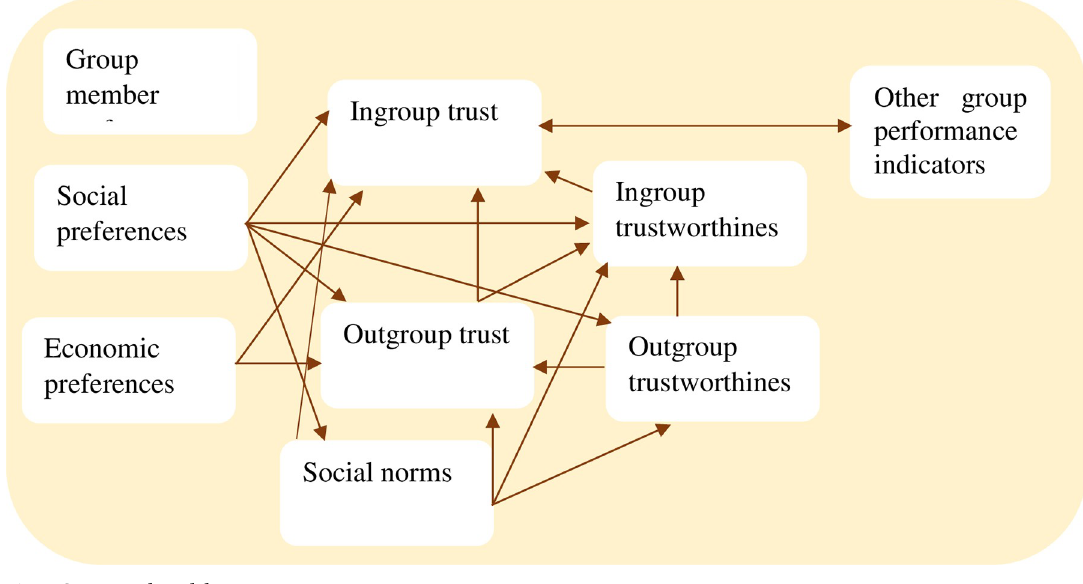
Fig 1. Conceptual